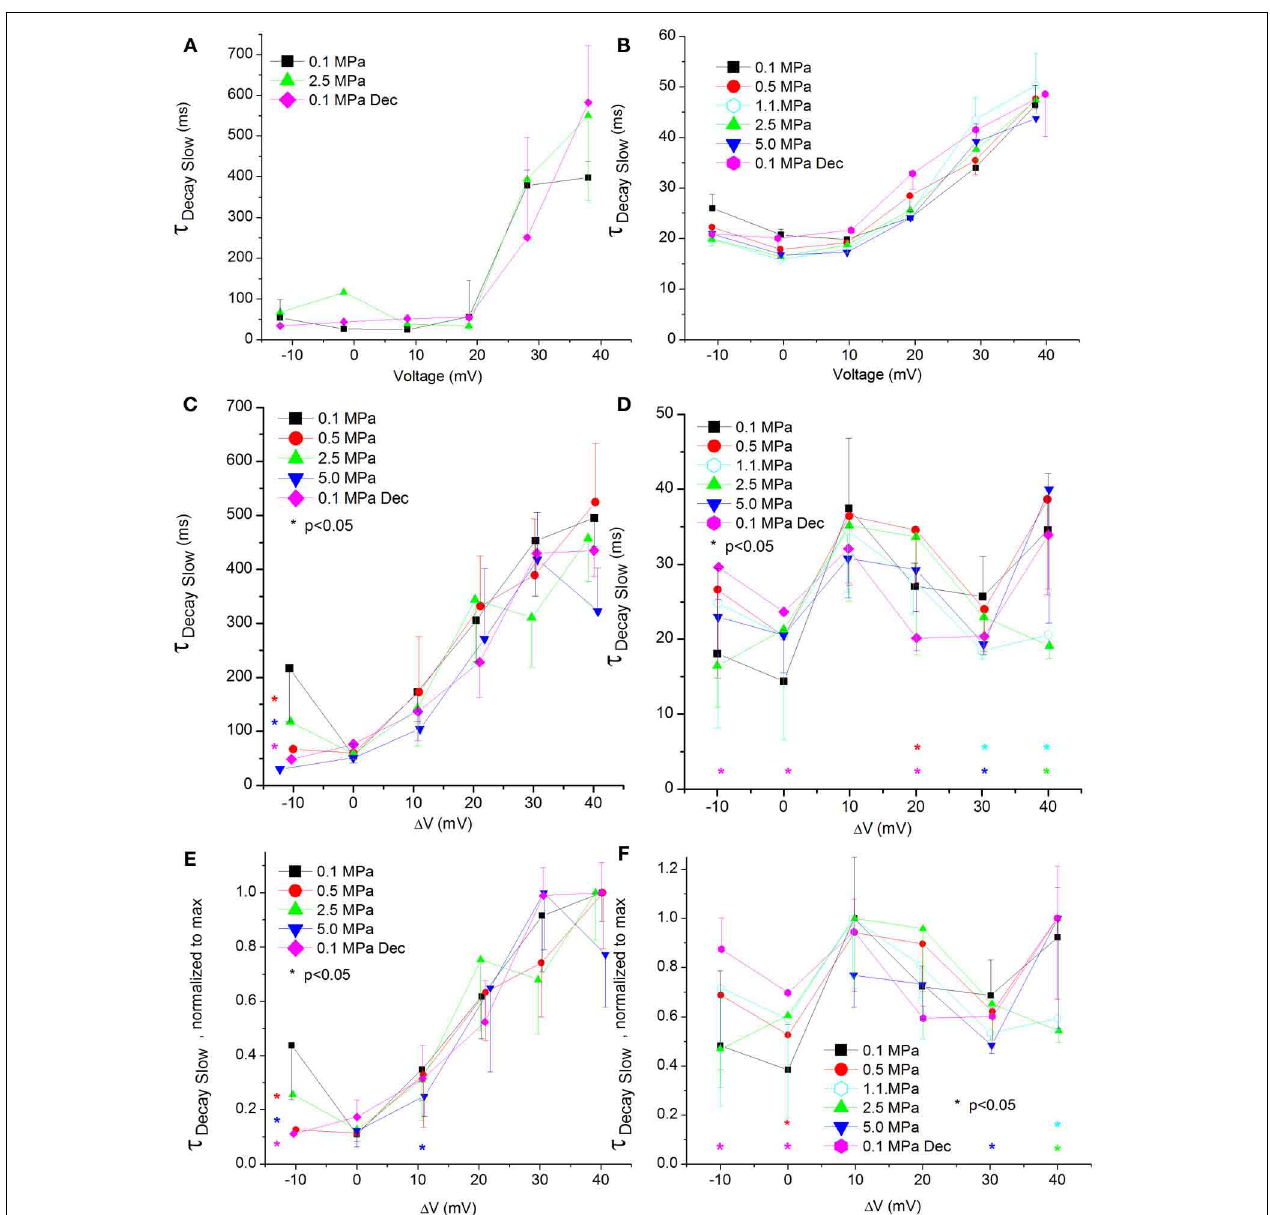
FIGURE 9 | Slow time constant of voltage- and time-dependent current inactivation ( Decay Slow ). (A,C,E) in Ca V 1.2 and (B,D,F) in Ca V 3.2 channels. (A,B) Decay Slow measured in a single oocyte. (C,D) Pooled data of the channels Decay Slow . (E,F) Normalized Decay Slow :